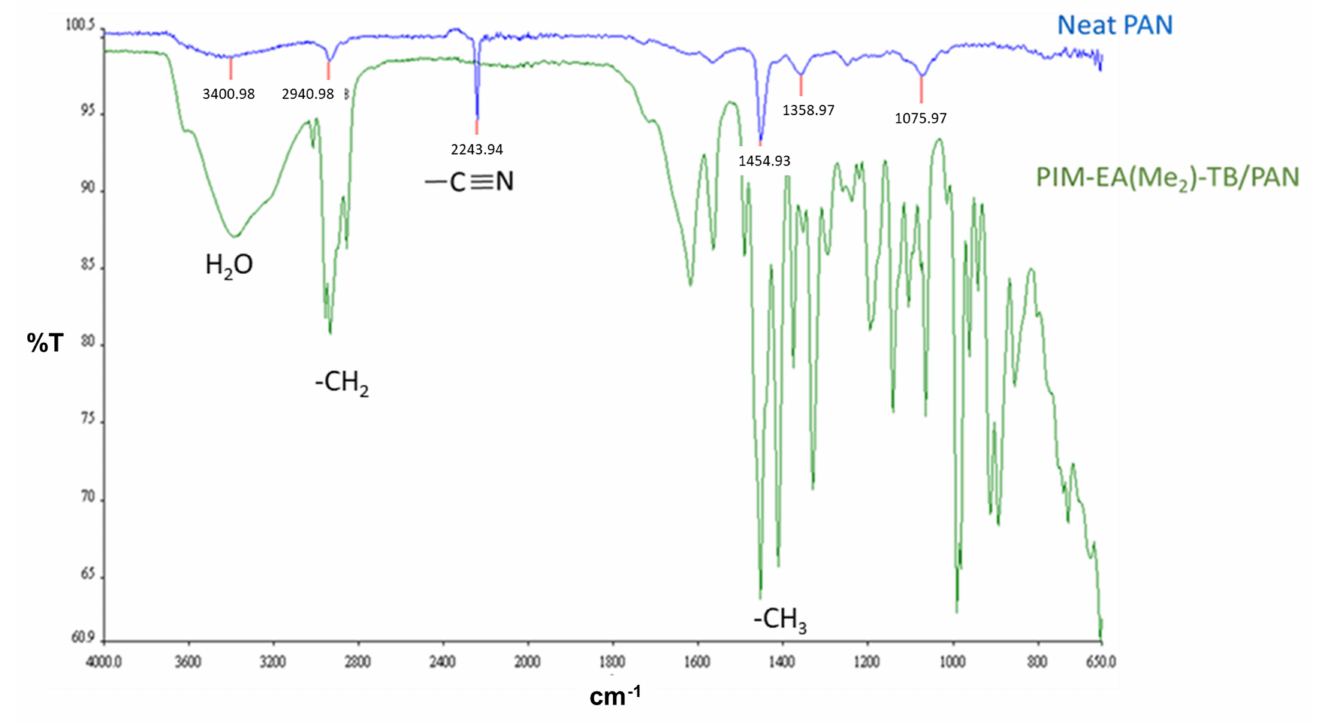
Figure 5. Attenuated total reflection FT-IR spectra of the top surface of the pristine Synder PAN 30 kDa porous support (blue), and the support with the neat PIM-EA(Me 2 )-TB coating